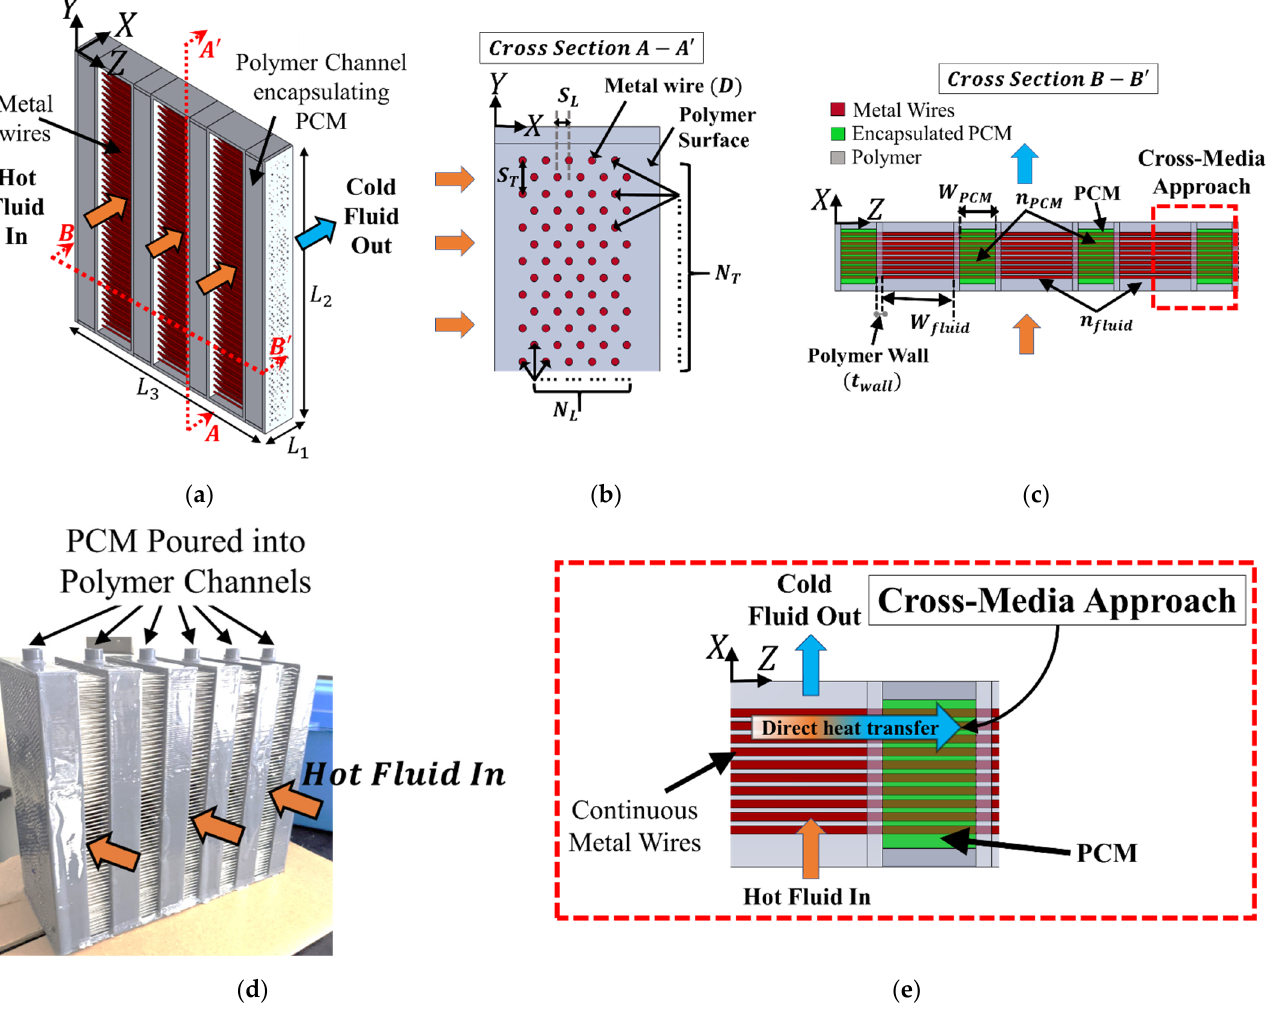
Figure 1. Design of TES system: ( a ) isometric view; ( b ) cross ‐ sectional view of XY plane showing metal wires in tube ‐ bank geometry; ( c ) cross ‐ sectional view of XZ plane with cross ‐ media approach marked in dashed border rectangle; ( d ) picture of an additively manufactured TES system at the AHXPI laboratory [35]; ( e ) cross ‐ media approach leading to melting of PCM.